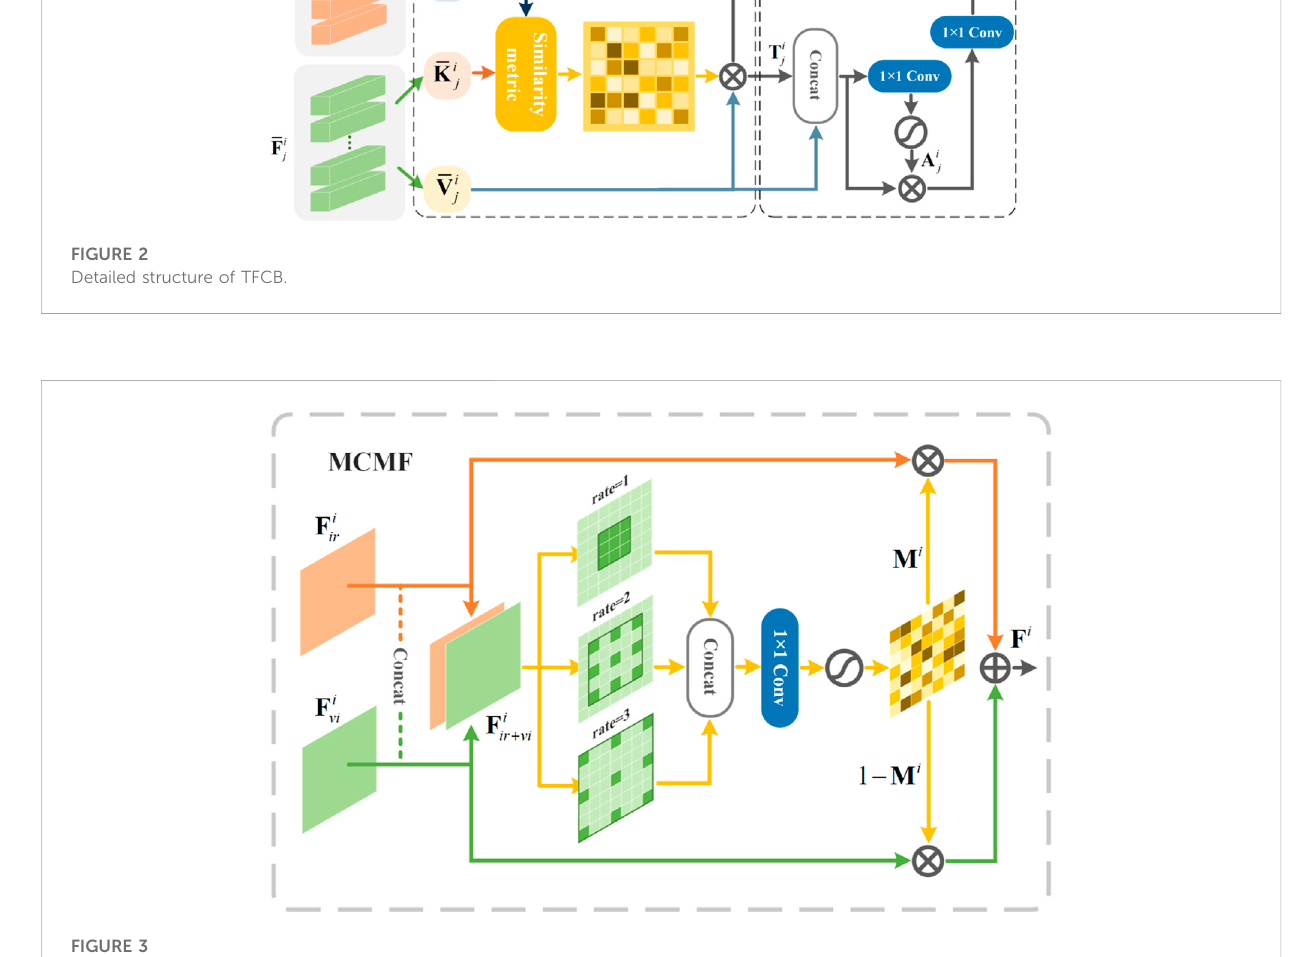
FIGURE 3 Detailed structure of